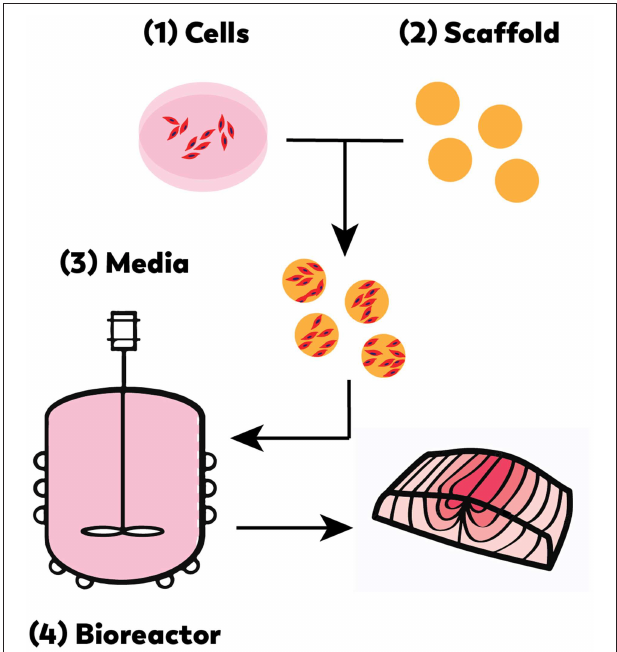
FIGURE 3 | Cell-based seafood production will require the appropriate: (1) cell line(s), (2) compatible scaffold, (3) medium, and (4) bioreactor ( Edelman et al., 2005